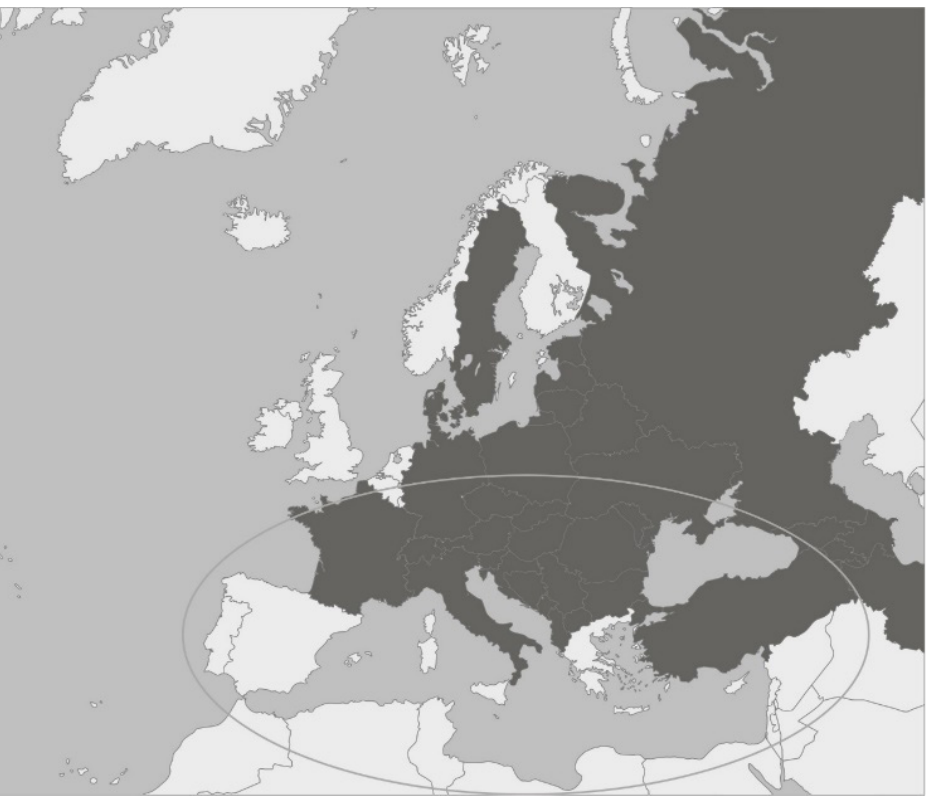
Figure 1. Native distribution of Valeriana officinalis